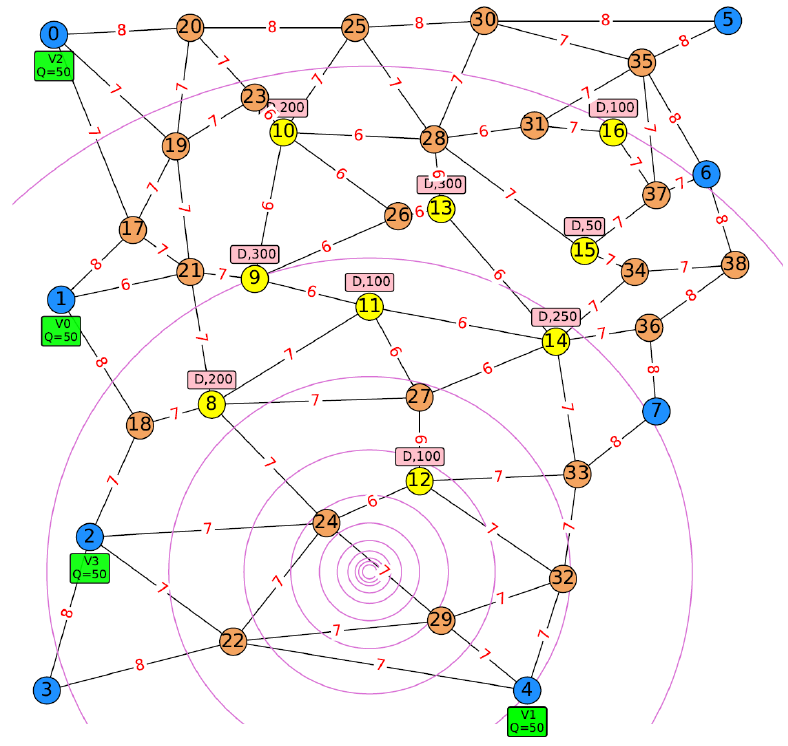
Figure A7. Road network for instance